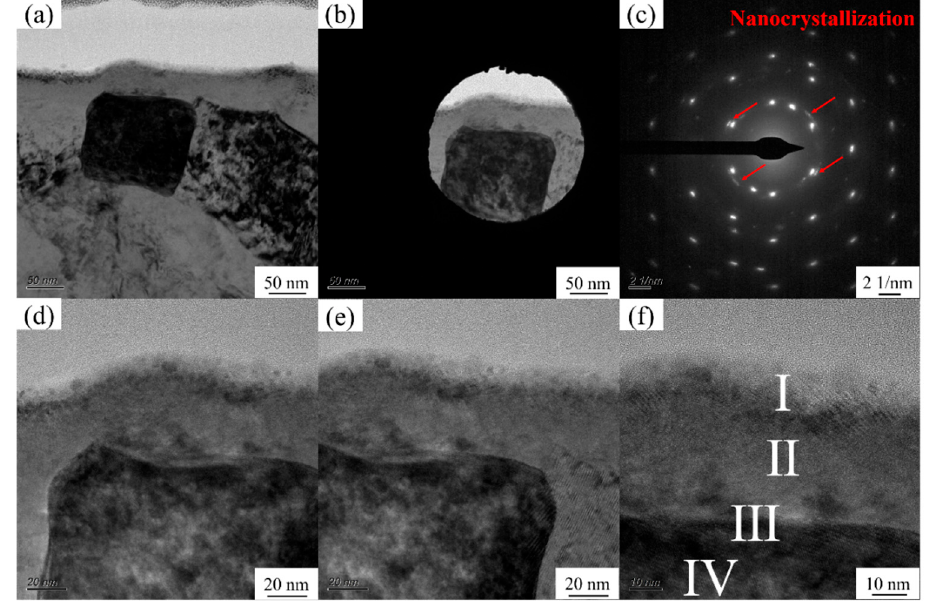
Figure 7. The TEM bright field images of the cross section for Ag-implanted layer and the diffrac- tion pattern of corresponding selection: ( a , d – f ) the TEM bright field images; ( b , c ) the selected area and its corresponding diffraction pattern.